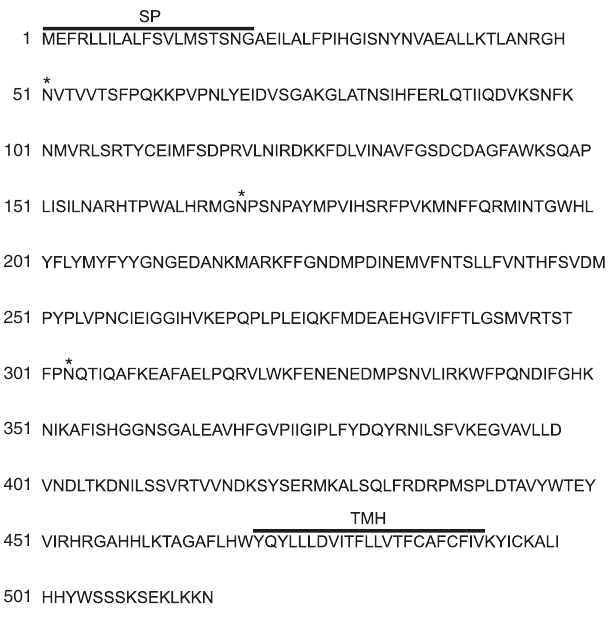
Fig. 7 DcUGT2 protein sequence. Protein transmembrane topology and signal peptide were predicted by the Phobius sever (accessible at http:// phobius.binf.ku.dk). N-glycosylation sites were predicted by the NetNGlyc 1.0 server (accessible at http://cbs.dtu.dk/services/NetNGlyc/). TMH putative transmembrane helix; SP putative cleavable signal peptide; asparagine (N) residues are indicated with an asterisk: potential N-